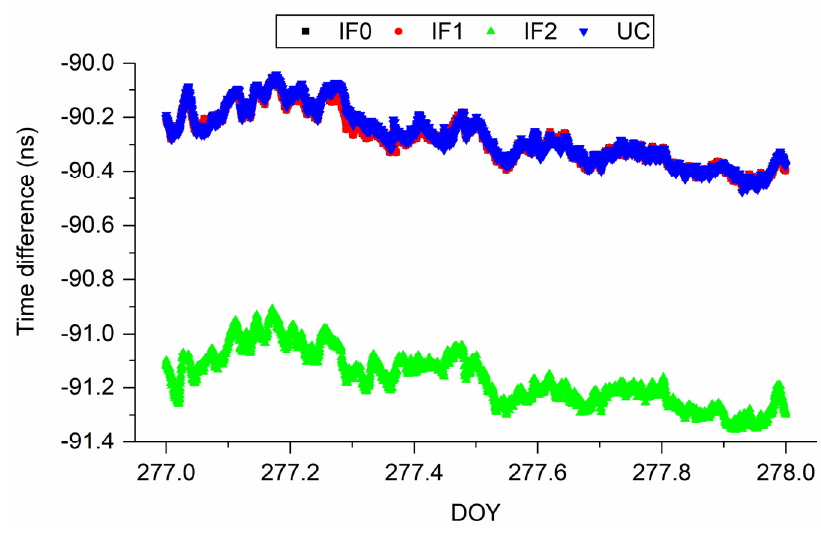
Figure 9. Comparison of time difference of BRUX-PT11 obtained from different models on DOY 277, 2019.